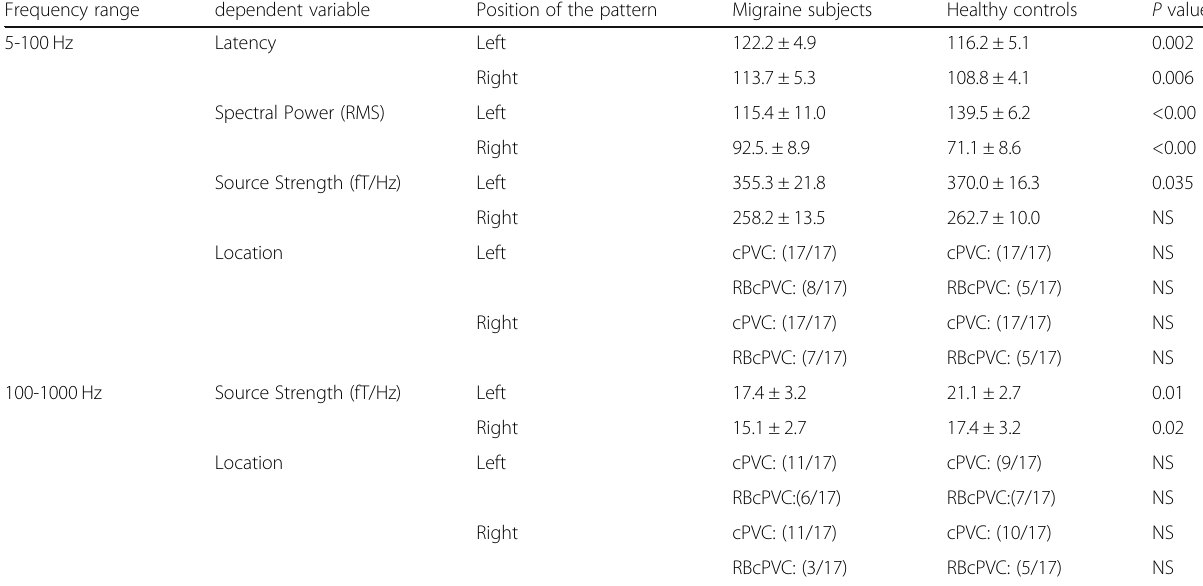
Table 2 The main dependent variables analyzed in the MEG spectrograms for migraine subjects and controls Frequency range dependent variable Position of the